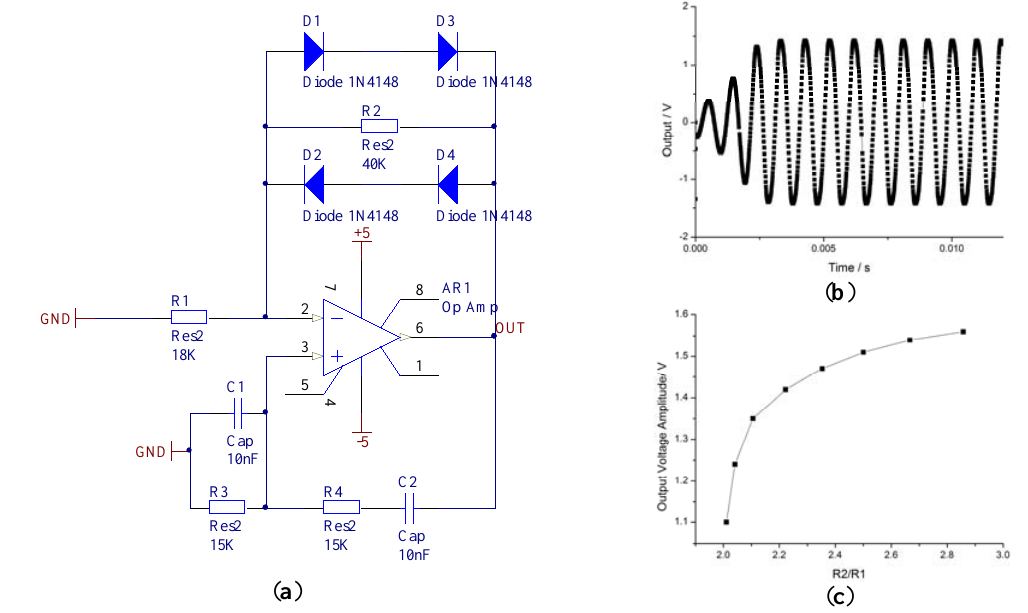
Figure 4. ( a ) Simulation model of the Wien bridge circuit; ( b ) simulation output of the OUT point; ( c ) relationship between R2/R1 and output voltage.